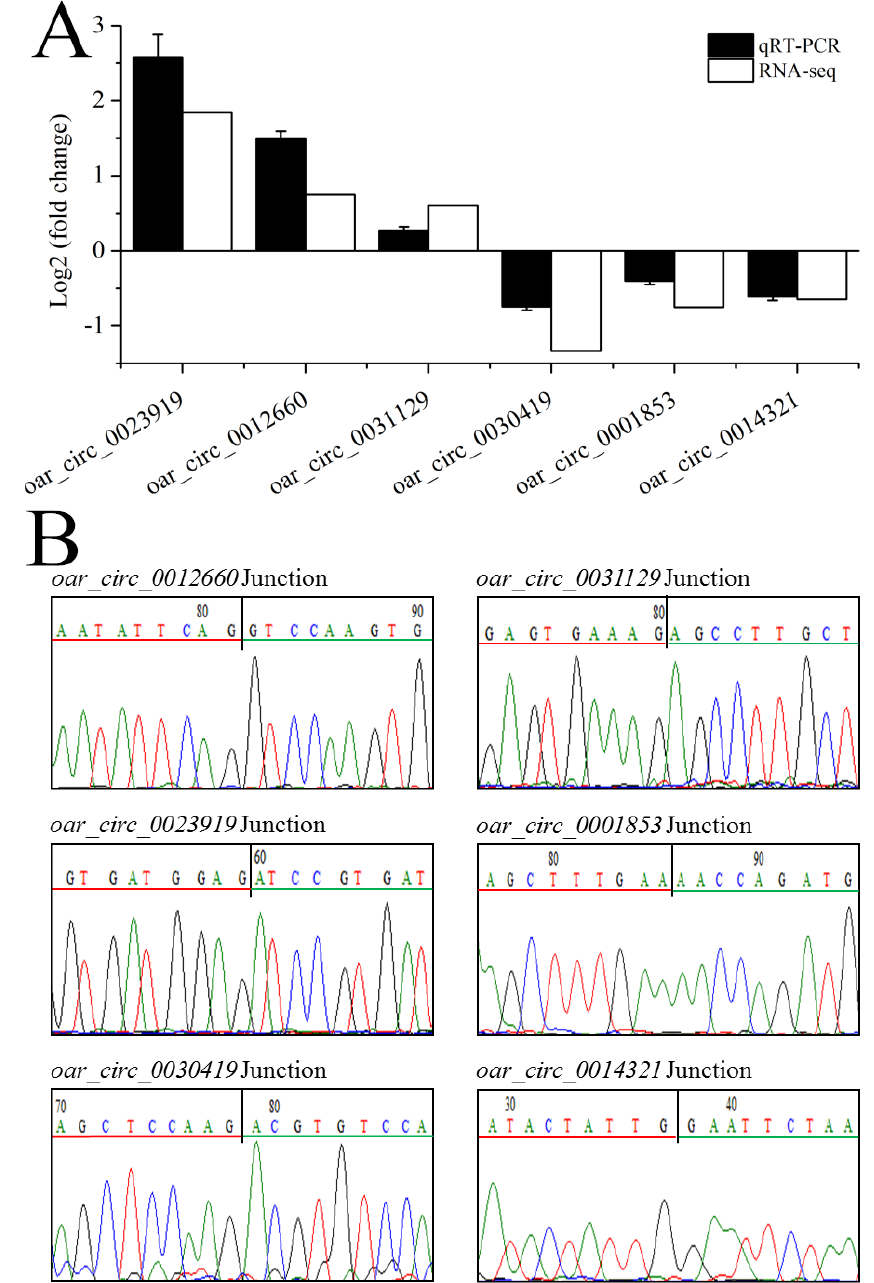
Figure 6. Validation of circRNA expression by qRT-PCR and Sanger sequencing. ( A ) qRT-PCR verification of di ff erentially expressed circRNAs. ( B ) Back-spliced junctions of the six randomly selected circRNAs was confirmed by Sanger sequencing. The black vertical line represents the back-spliced junction sites. Green and red horizontal lines indicate the 5’ and 3’ ends of the circRNA sequence, respectively.